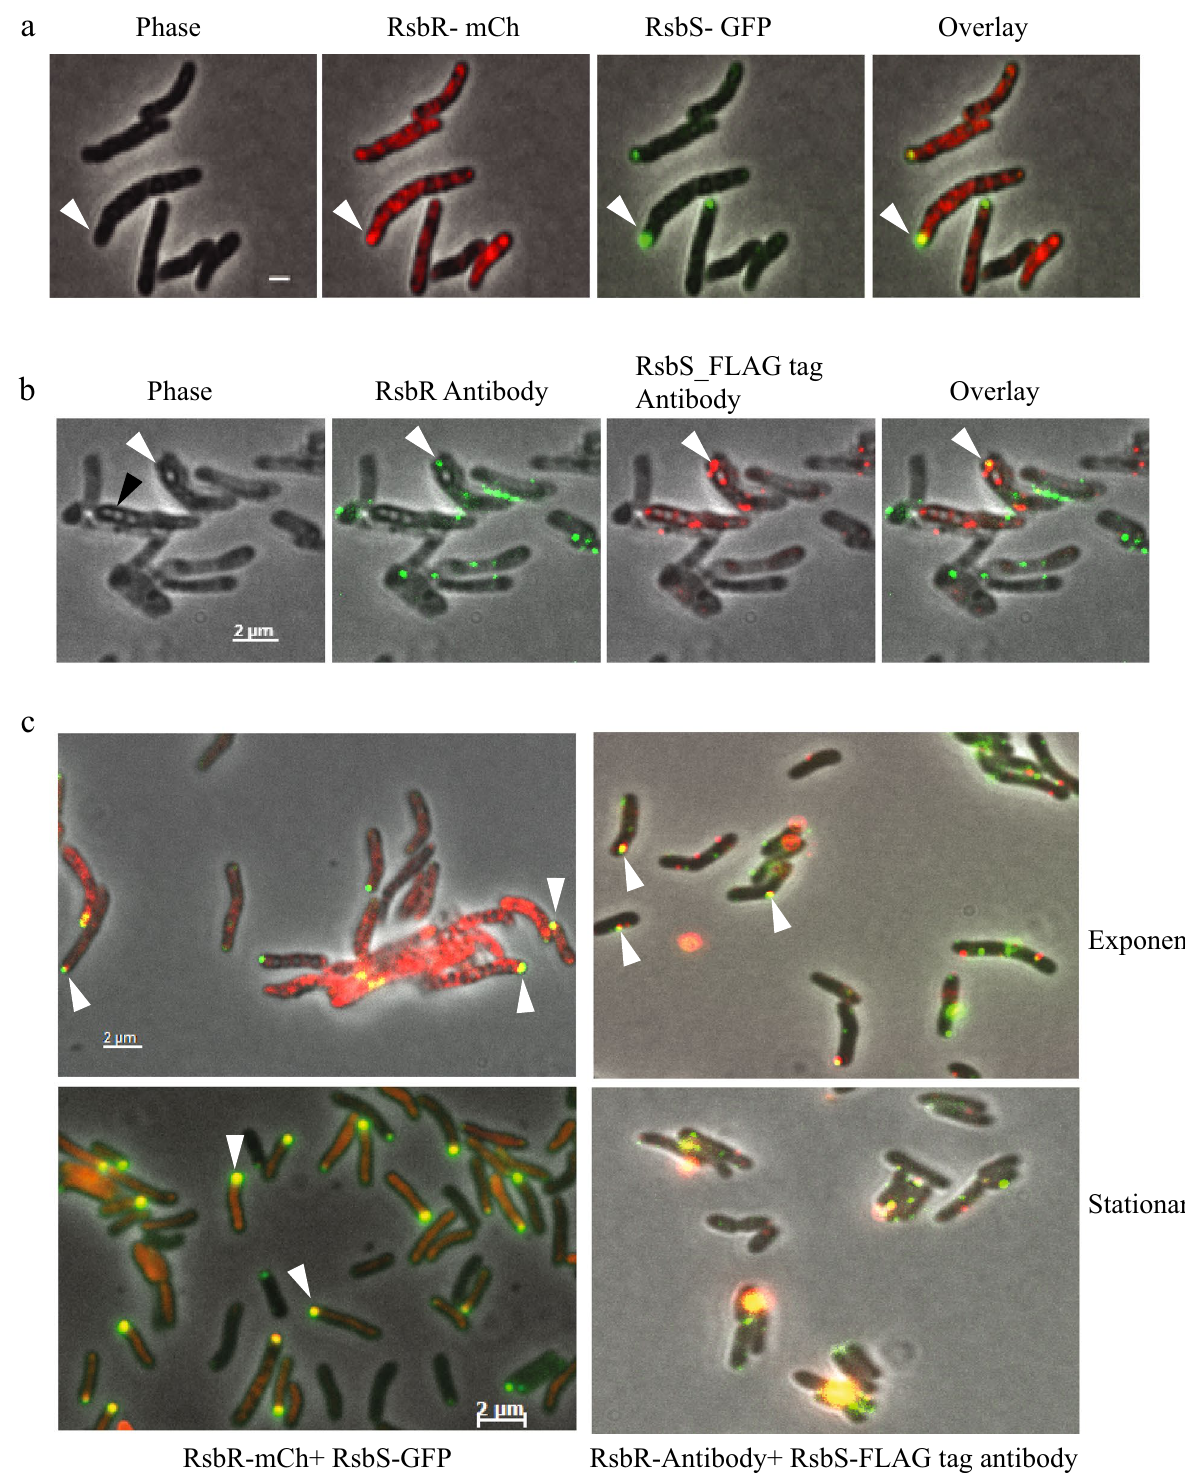
Figure 5. Co-localization of RsbR and RsbS in Mmar T cells. ( a ) Shows the individual fields of RsbR-mCh, RsbS-GFP and an overlay with yellow spots representing the co-localization in exponential phase cells of Mmar pST2K-RsbR-mCherry-RsbS-GFP , scale bar = 1 μm. ( b ) Co-localization of RsbR and RsbS in Mmar pSTKiT-RsbS-FLAG by immunofluorescence using antibodies against RsbR (secondary antibody tagged with Fluorescein—green) and against FLAG for RsbS (secondary antibody tagged with Alexafluor594—red). Yellow spots represent the RsbS- RsbR co-localization. ( c ) Shows co-localization of RsbR-RsbS (yellow spots indicated by white arrows) by fusion (first column) and immunofluorescence (second column) at exponential phase (top panel) and stationary phase (bottom